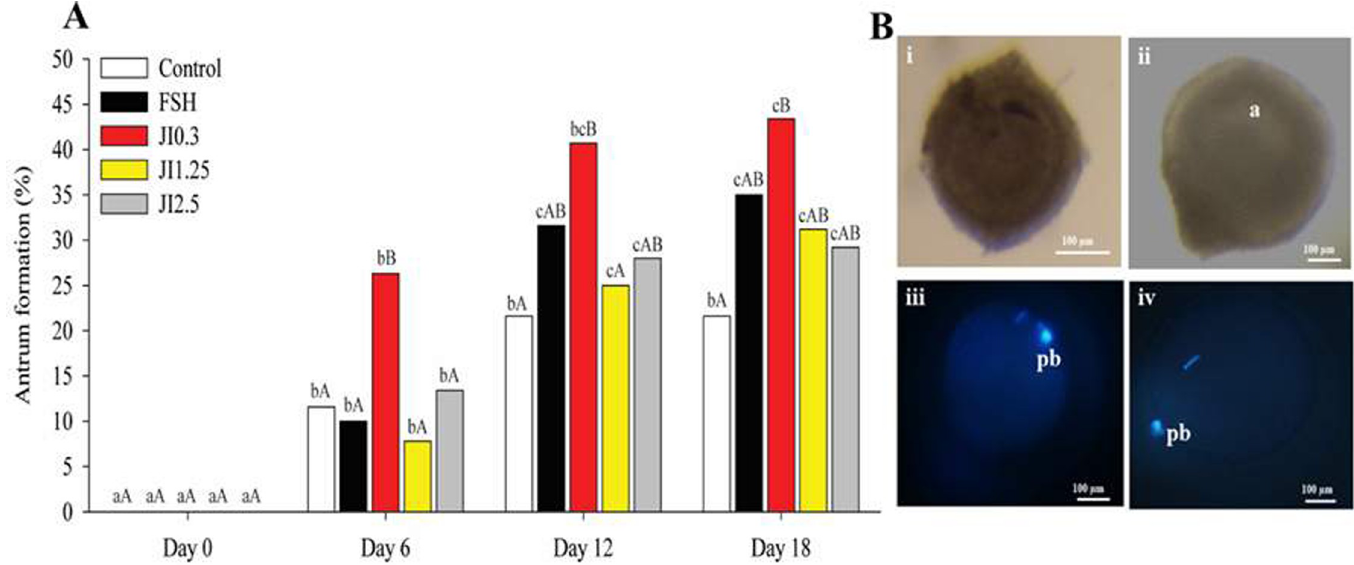
Fig 4. Percentage of antrum formation (A) at different time point (D0, D6, D12, D18) in MEM + (Control), FSH or in J . insularis 0.3, 1.25 or 2.5 mg/mL (JI0.3, JI1.25 or JI2.5 respectively). (B) : Normal sheep secondary follicle at D0 (i) or at D18 day in J . insularis 0.3 mg/mL (JI0.3) (ii). Note formation of antrum (a) on D18. Representative images of fluorescent metaphase II oocyte grown in vitro (iii) or in vivo (iv). Note presence of the first polar body (cp). D: day, MEM + : Minimal essential medium supplemented, FSH: recombinant bovine follicle stimulating hormone, JI: J . insularis . A total of 342 secondary follicles were distributed in the different treatments (n = 6 replicates. a,b,c,d Different letters denote significant differences among time for a given treatment group (P < 0.05). A,B Different letters denote significant differences among treatment groups within the same time point (P <